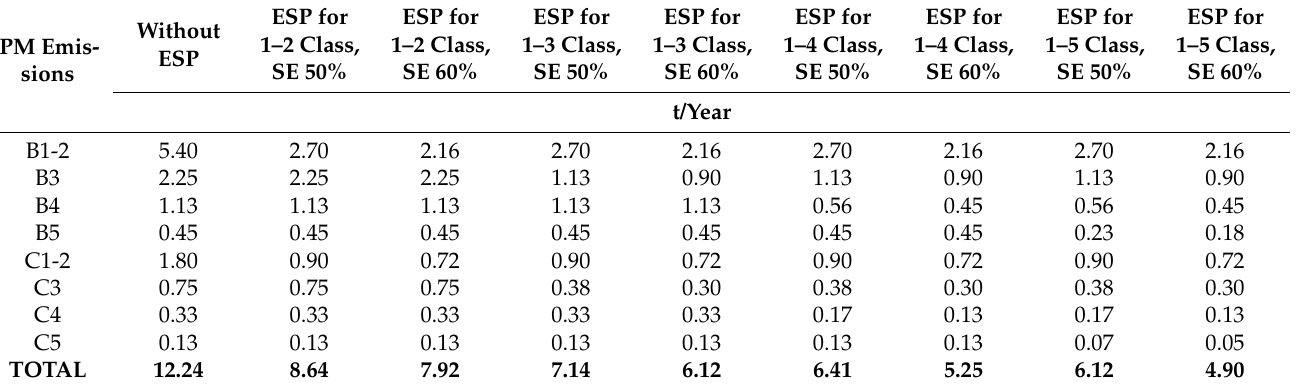
Table 1. Total PM production in the model village without the use of ESPs and with different scenarios of the ESP use.